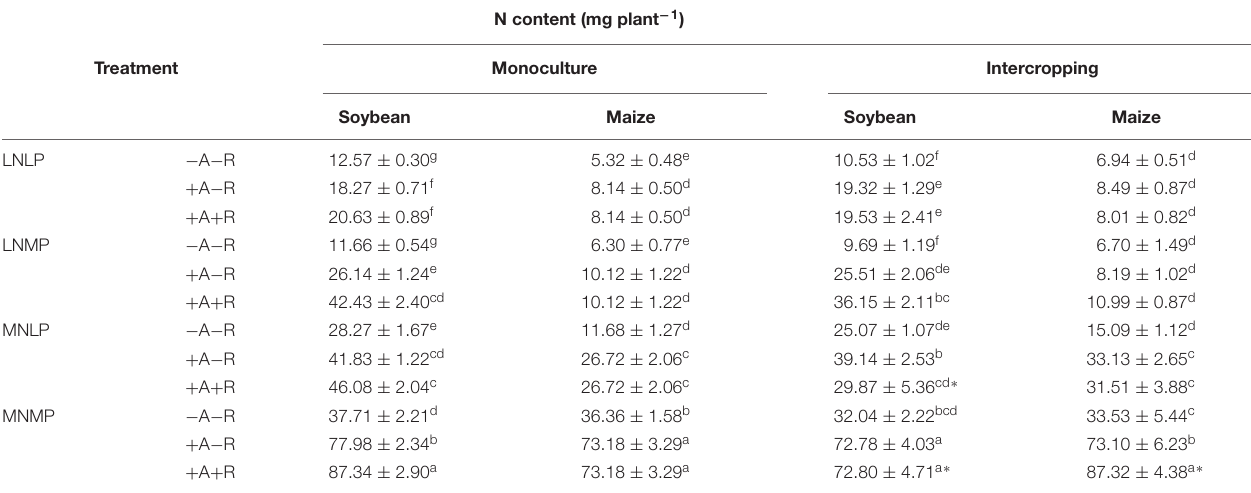
Data in the table are the mean of four replicates with standard error. Different letters indicate significant differences among nutrient treatments within a cropping system and crop species (Duncan’s multiple range test, P < 0.05). Asterisks indicate significant differences between monoculture and intercropped plants within a crop species and nutrient treatment (LSD test, P < 0.05). LNLP, low N and P; LNMP, low N and moderate P; MNLP, moderate N and low P; MNMP, moderate N and P.